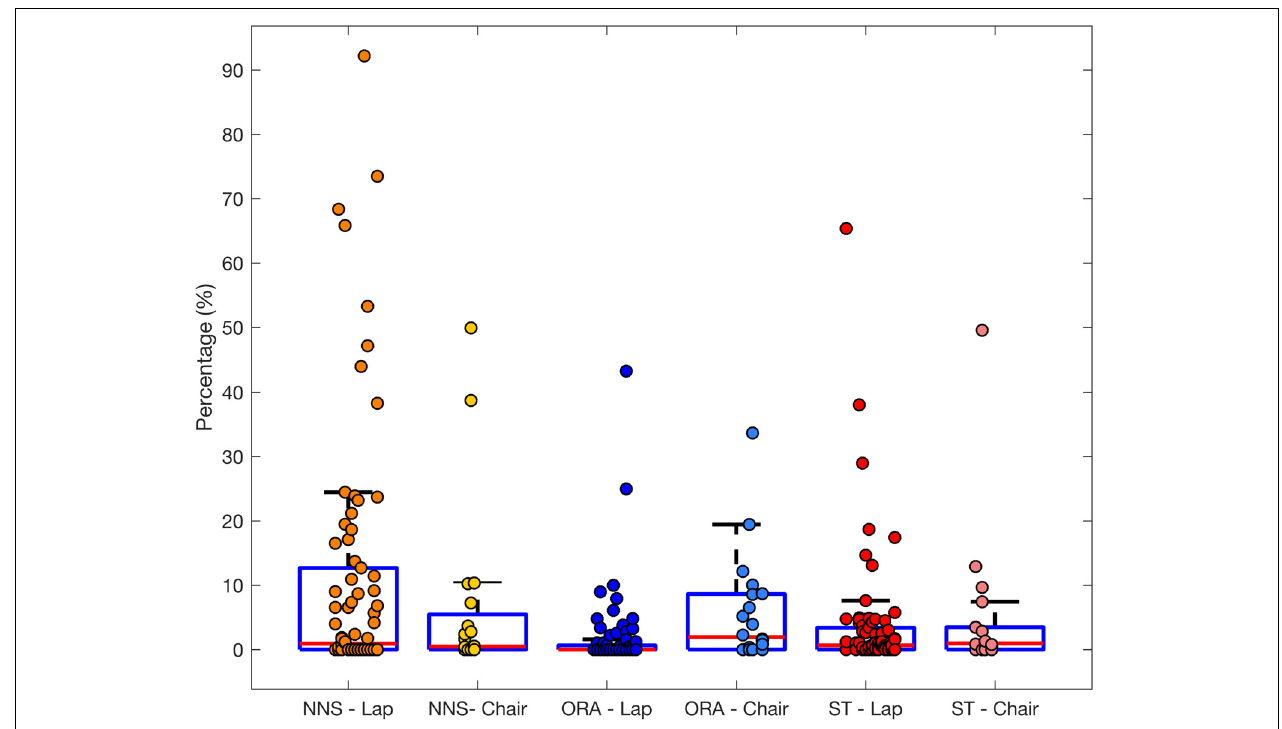
FIGURE 3 | Boxplot with overlaid dots (individual participants) representing the total duration of non-nutritive sucking (NNS), object-related activity (ORA) and self-touch for infants seated on a lap ( n = 74) or a chair ( n = 20).